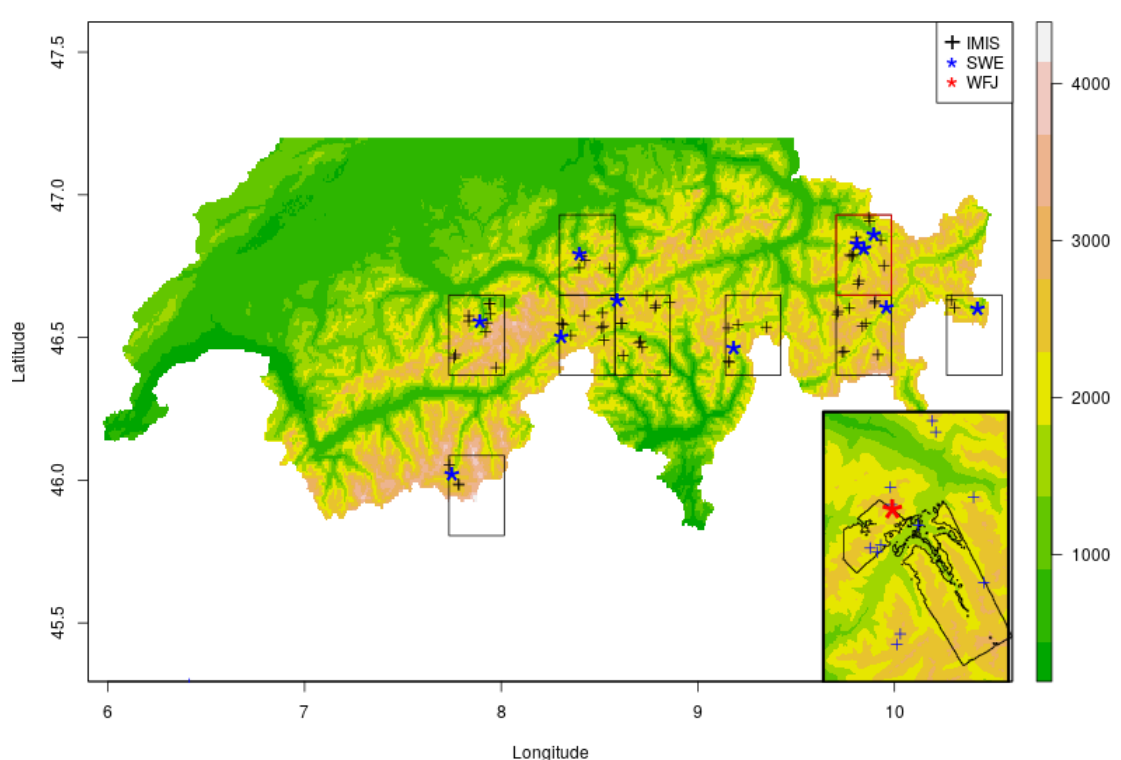
Figure 2. Experimental set-up: the nine ERA5 grid boxes were selected based on the fact that they contained GCOS SWE monitoring sites (11 stations). All of the IMIS stations in each box are used for evaluation (39 stations). The Weissfluhjoch research station and the flight path of the ADS data are located in the red box, which is also shown at a larger scale in the inset.